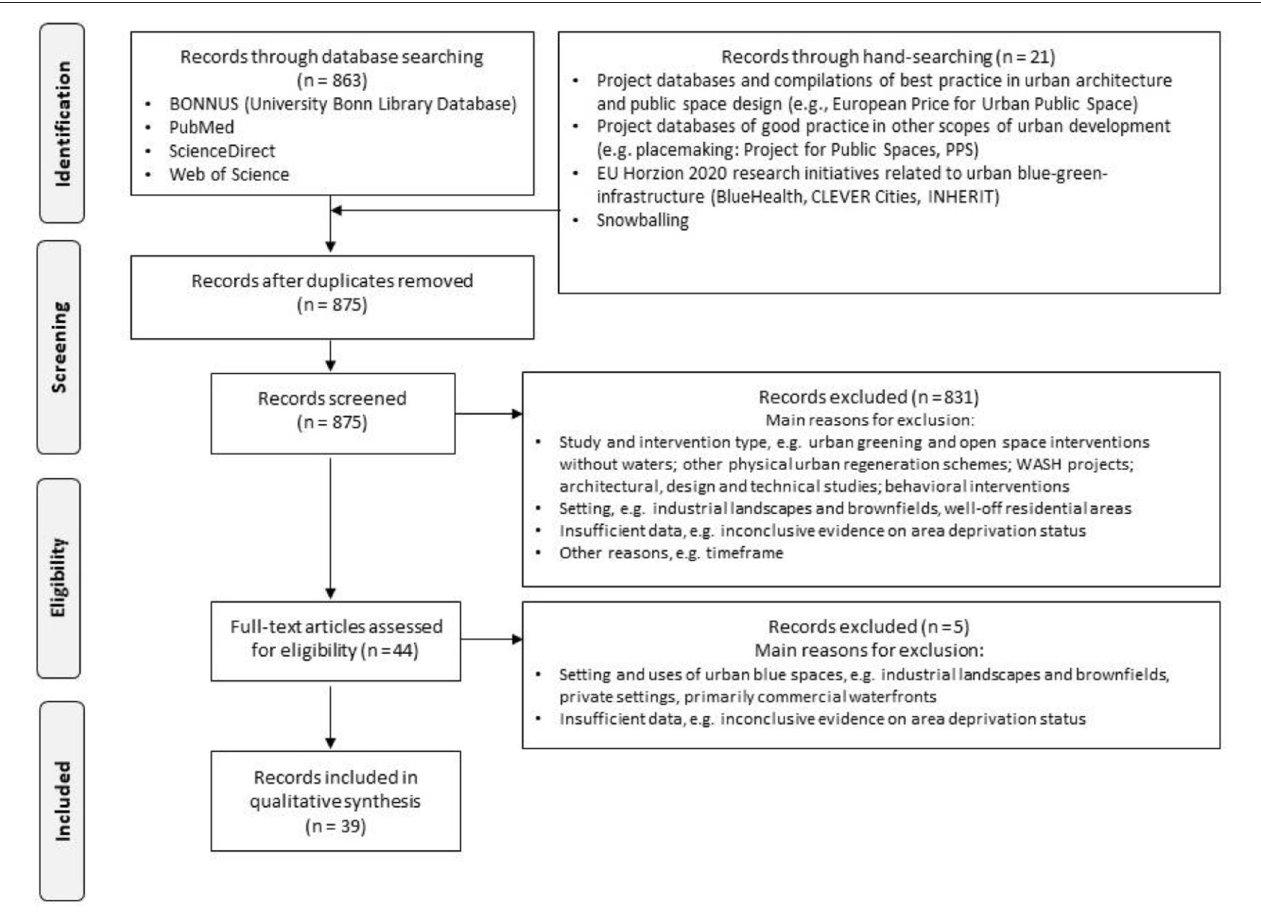
FIGURE 1 | Selection of review projects following the PRISMA flow chart according to